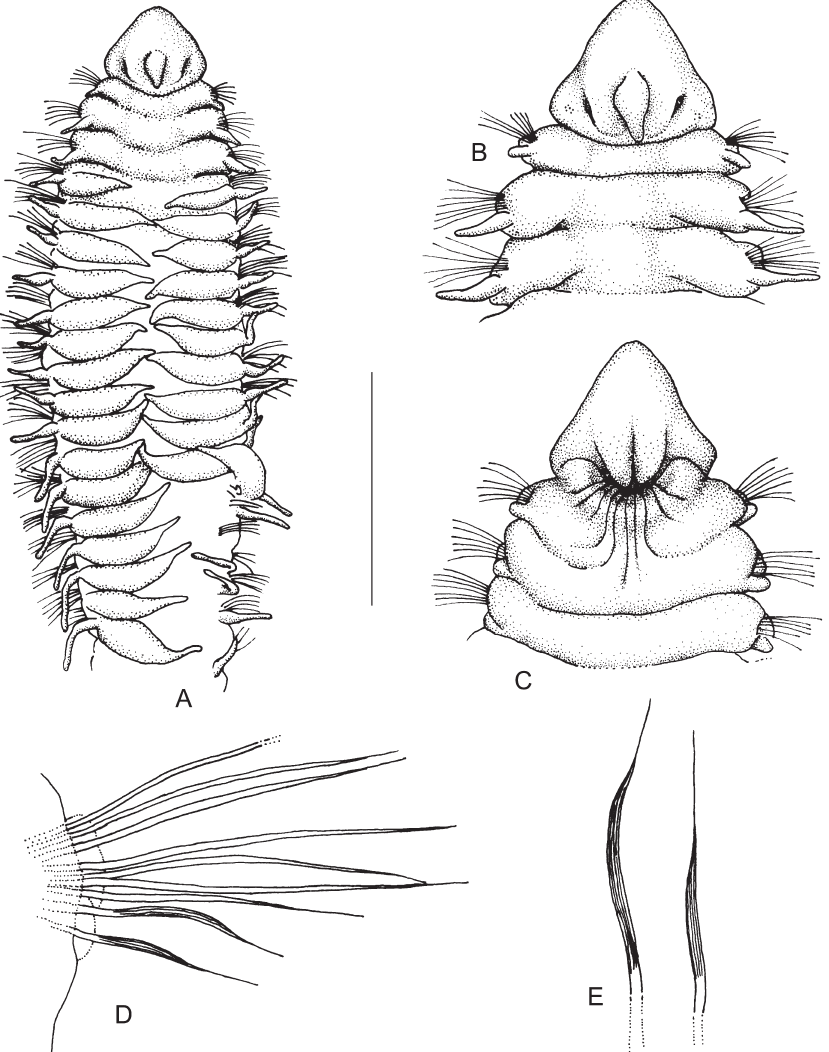
Fig . 18. – Aricidea ( Allia ) mirunekoa n. sp.: A-b, anterior region, dorsal view; c, anterior region, ventral view; Holotype (Mncn 16.01/11209) D, neuropodium, chaetiger 27; Holotype (Mncn 16.01/11209) e, modified ventral chaeta, chaetiger 27. Scale bar: A 415 µ m; b 425 µ m;